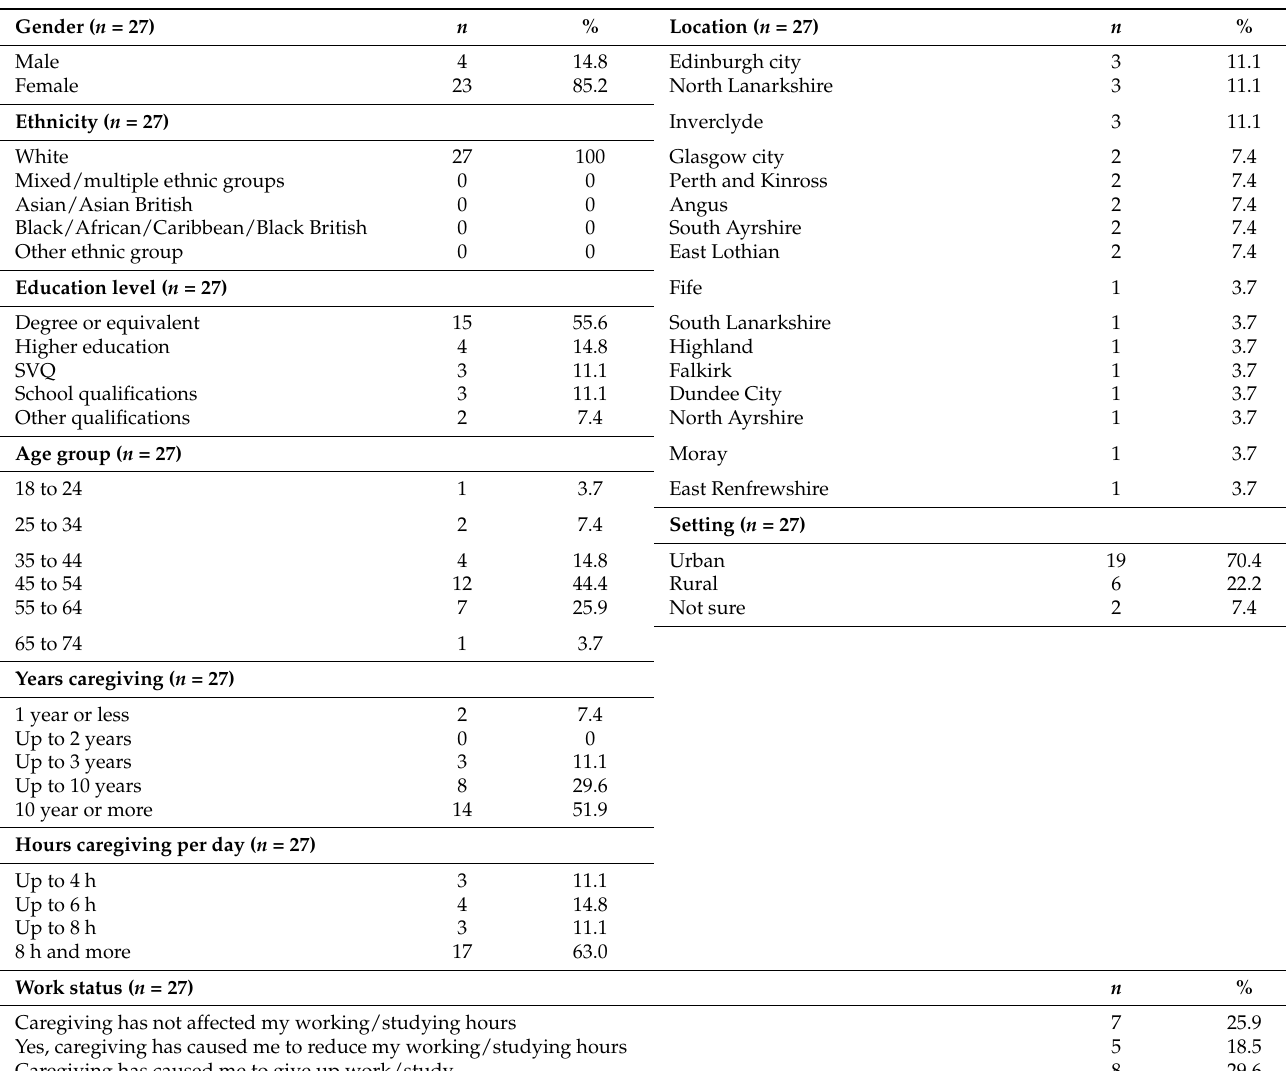
Table 1. Demographic information of participants collected at